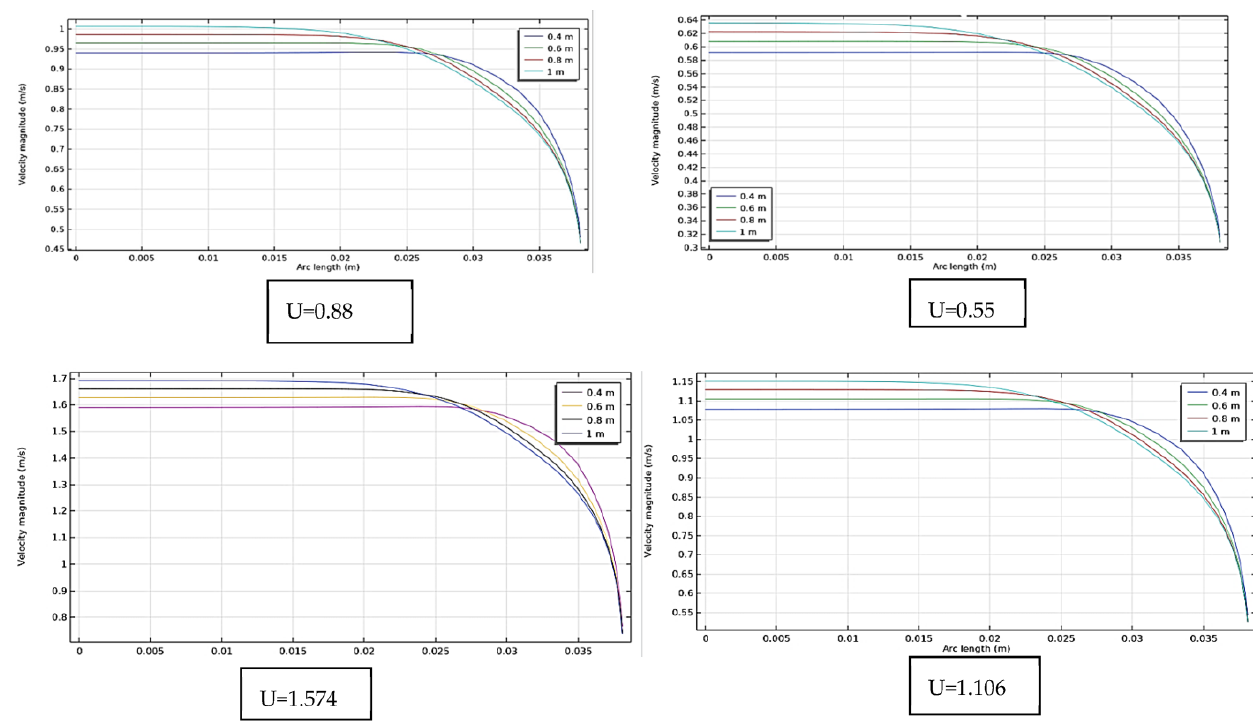
ChemEngineering 2023 , 7 , x FOR PEER REVIEW